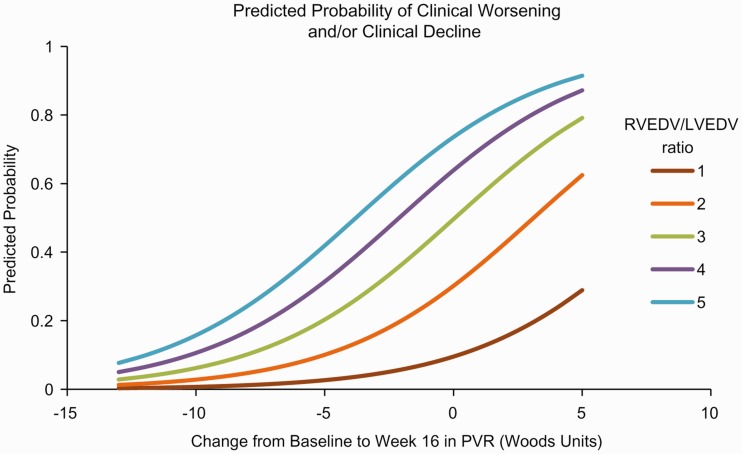
Competing outcomes plot.